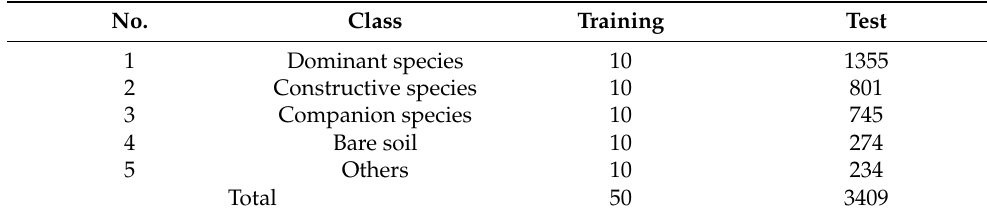
Table 1. Number of training set and test set samples.